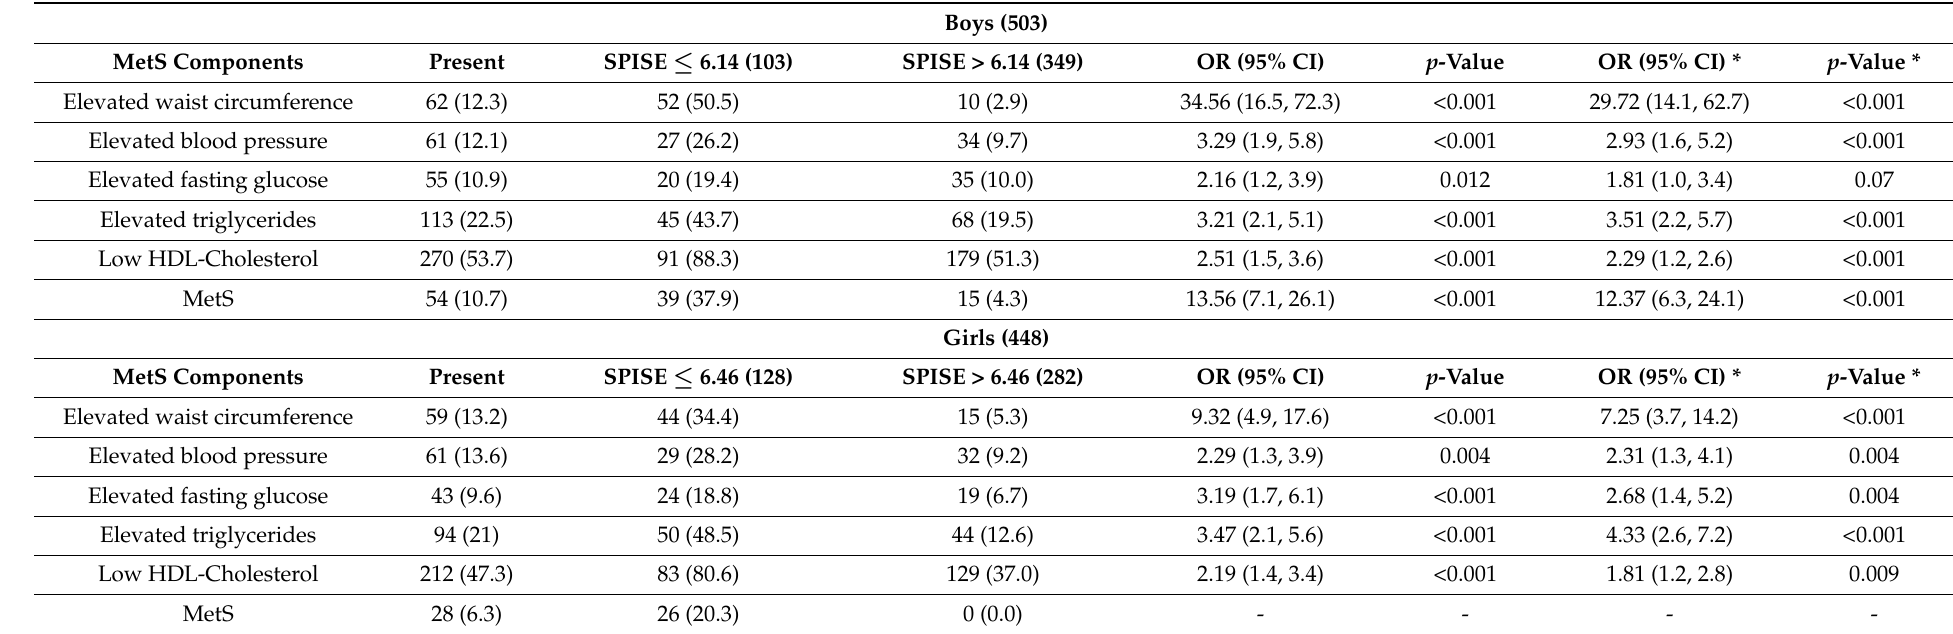
Table 4. Prevalence of MetS components in groups formed using cutoff in SPISE